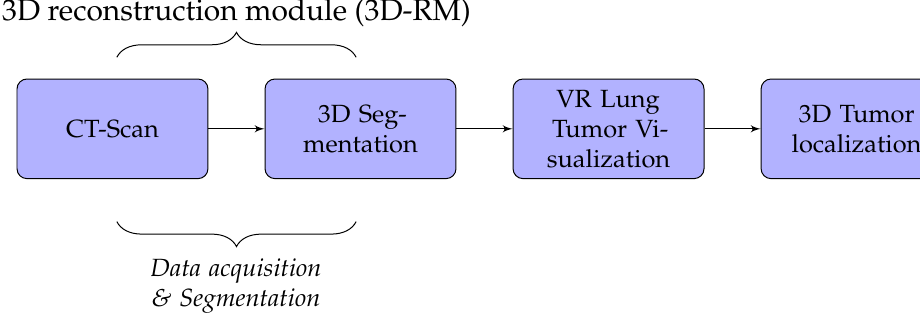
Figure 1. Fundamental modules